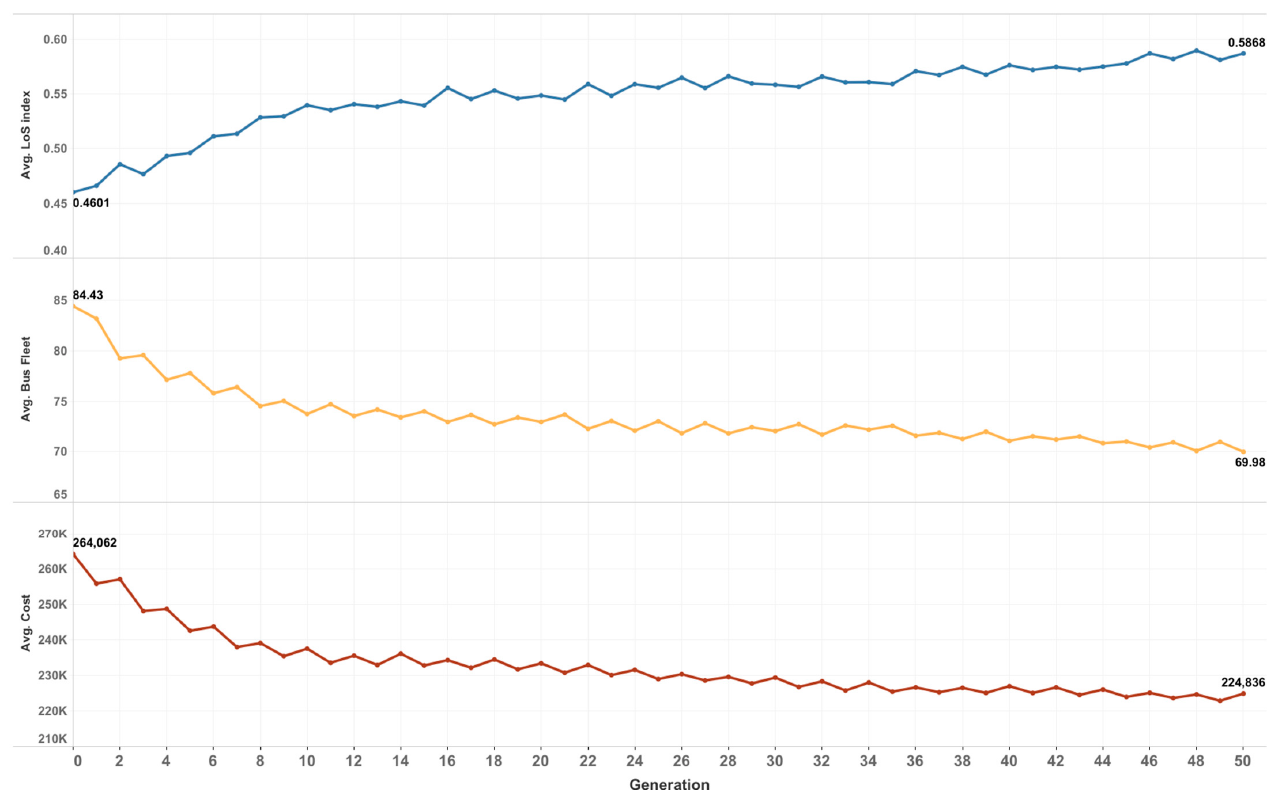
Figure 10. User Cost, Operator Cost (fleet) & average vehicle LoS index (total passenger load/total fleet capacity).